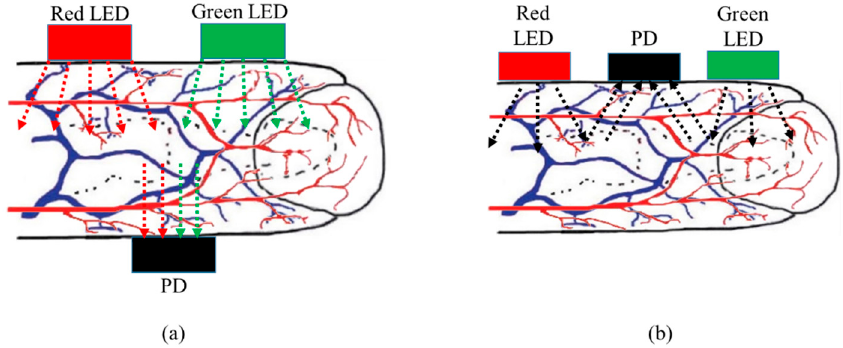
Figure 3. PO types: ( a ) transmission and ( b ) reflection. LED, light ‐ emitting diode; PD, photodetector.